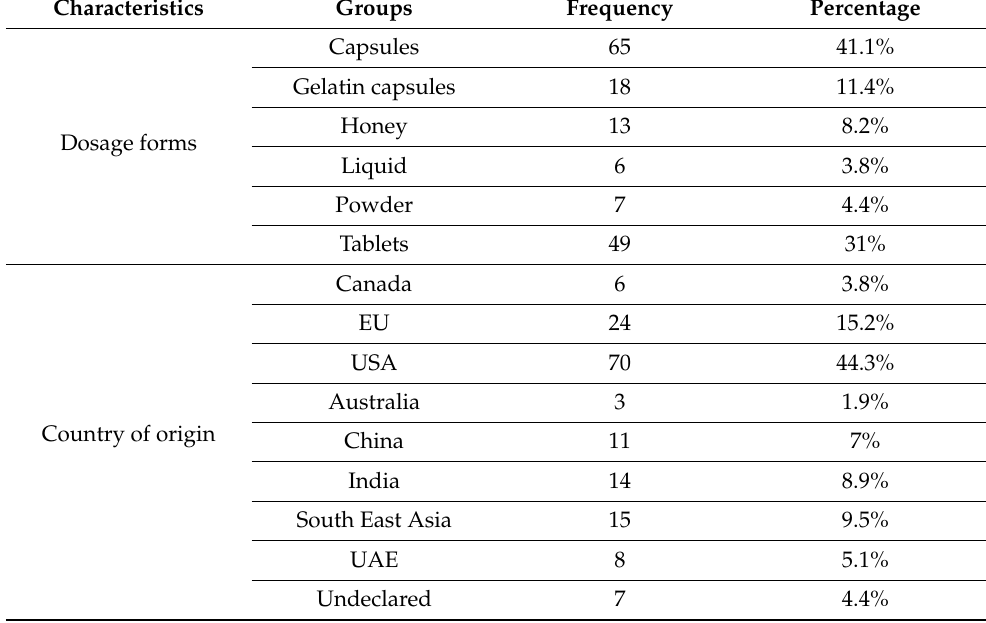
Table 1. Number and percentages of sample baseline characteristics ( n =